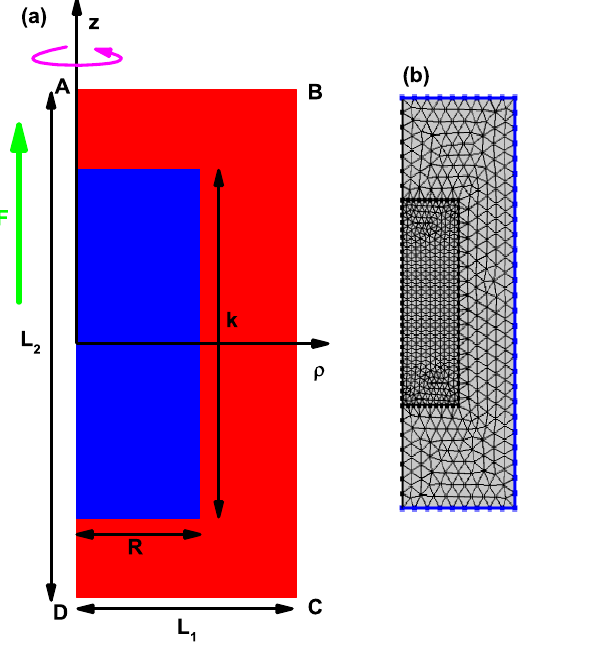
Figure 1. Schematic of the structure used to solve the two-dimensional eigenvalue differential equation, Equation (3), using the finite element method ( a ). In ( b ), the mesh used with its refinement in the QD region to implement the finite element method is shown. F represents the applied electric